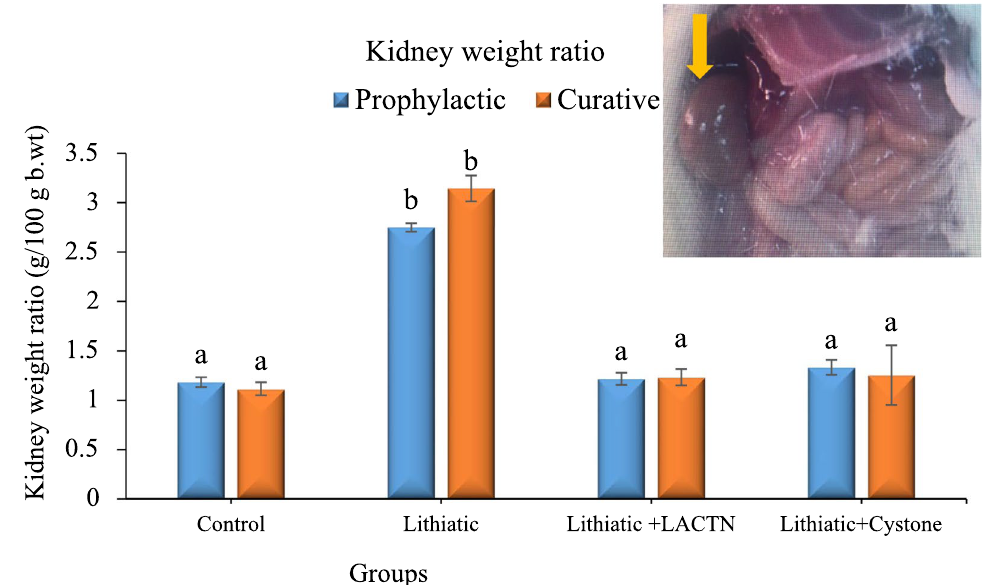
Fig. 3 Effect of LACTN on kidney weight of urolithiasis